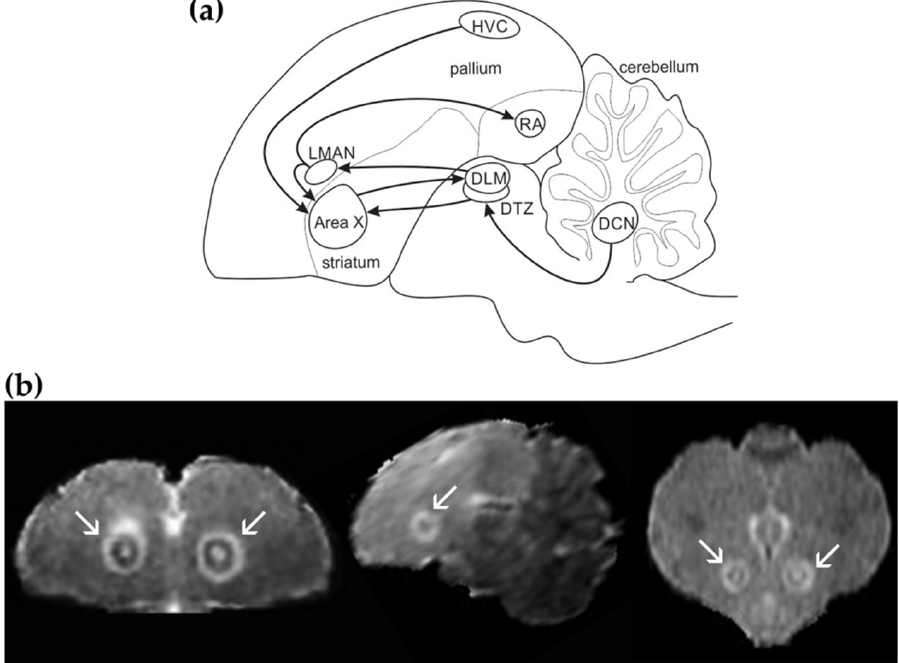
Figure 1. Brain circuitry and Area X lesion. ( a ) Schematic sagittal drawing of the song control system (SCS) in the songbird brain with delineated brain areas relevant to this study. Arrows are oriented in the direction of neuronal projections. Area X—vocal region of the striatum, DCN—deep cerebellar nuclei, DLM—the dorsolateral nucleus of the anterior thalamus, DTZ—dorsal thalamic zone, HVC—vocal nucleus (abbreviation used as proper name), LMAN—the lateral magnocellular nucleus of the anterior nidopallium, RA—robust nucleus of the arcopallium. The connectivity is based on previous studies [10,19]. ( b ) Magnetic resonance T2-weighted image of Area X on day 10 after excitotoxic injury showed in 3-orthogonal views (coronal, sagittal, and horizontal from left to right). The lesion spreads over the entire Area X. The hyper-intense border line due to edema is indicated by white arrows.